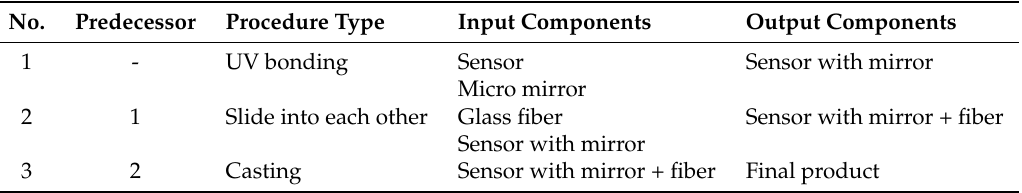
Table 1. An example for an assembly process based on the assembly sequence model in Figure 3.